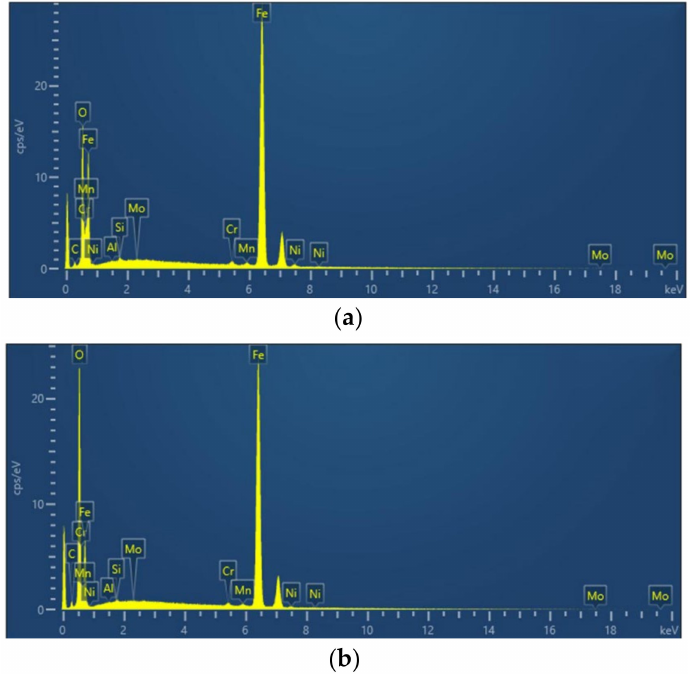
Figure 24. The EDS analysis results; ( a ) the EDS analysis results of area A in Figure 23 and ( b ) the EDS analysis results of the area B in Figure 23.